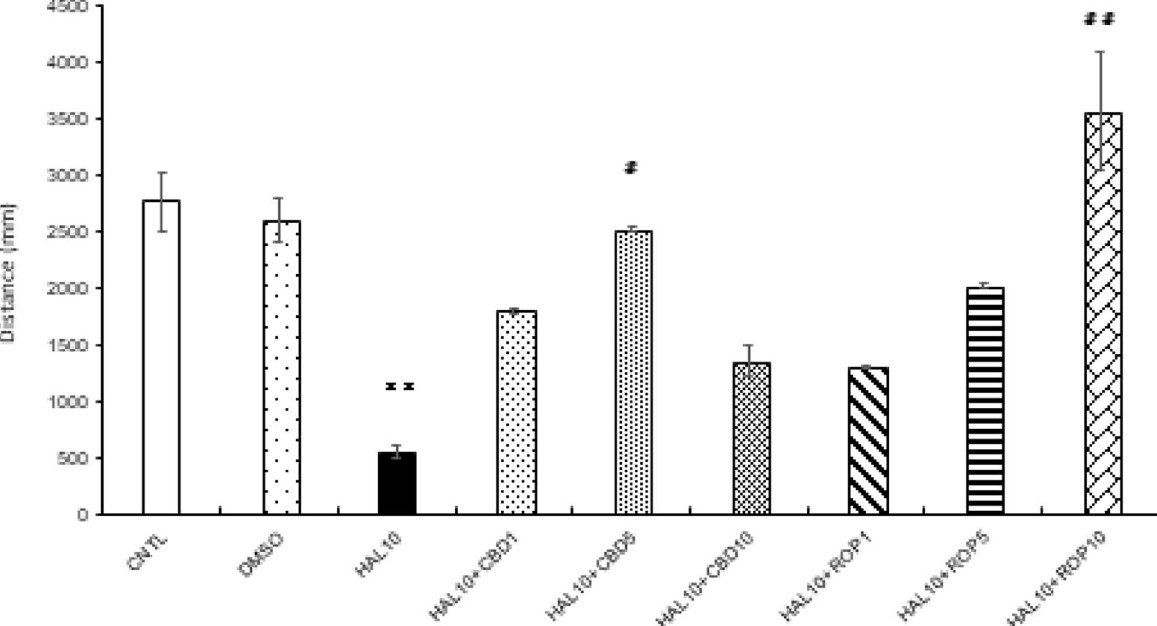
Fig. 2. The effect of CBD and ROP on activity of zebrafish Parkinsonism model. Addition of 1, 5, 10 mg/L of CBD to 10 mg/L of HAL clearly improved the distance traveled at 5 mg/L of CBD compared to 10 mg/L of HAL. When ROP was added at 1, 5, 10 mg/L to HAL 10 mg/L, the travel distance was clearly improved at ROP 10 mg/L compared with HAL 10 mg/L. In addition, there is no significant difference between the HAL10 CBD1 (mg/L), + HAL10 CBD5 (mg/L), HAL10 ROP1 (mg/L), HAL10 ROP5 (mg/L) and HAL10 ROP10 (mg/L) compared to the CNTL and DMSO groups. CNTL: + + + + Control, DMSO: dimethyl sulfoxide 0.05%, HAL10: Haloperidol 10 mg/L, CBD 1, 5, 10: Cannabidiol 1, 5, 10 mg/L, ROP 1, 5, 10: Ropinirole 1, 5, 10